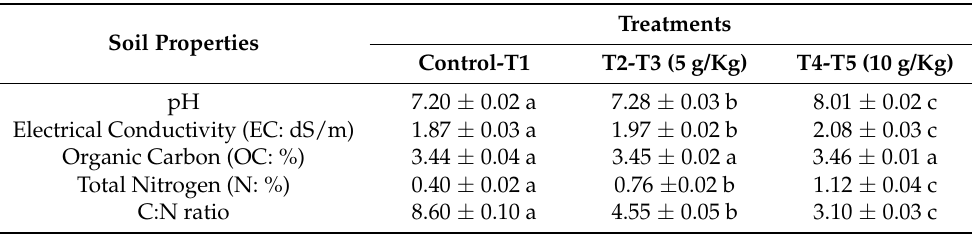
Table 2. Effect of the spent mushroom substrate (SMS)-based biochar supplementation on physico- chemical and nutrient properties of arable